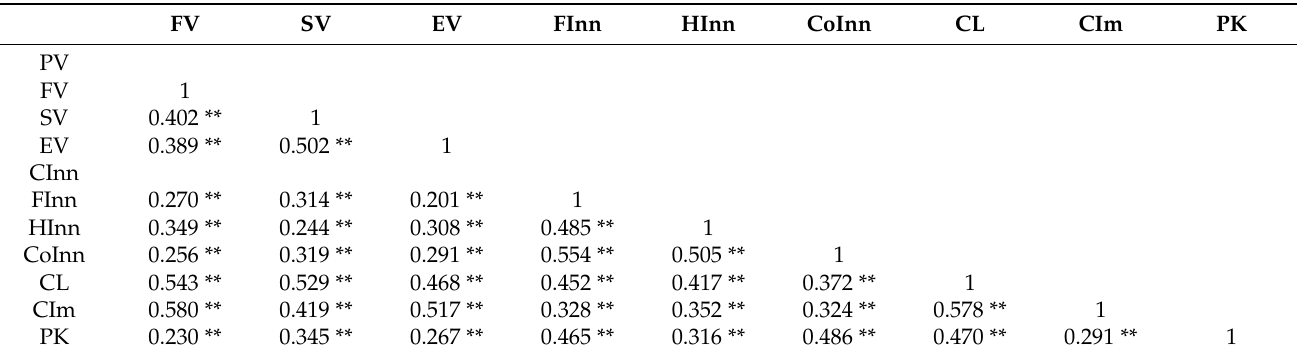
Table 4. Correlation